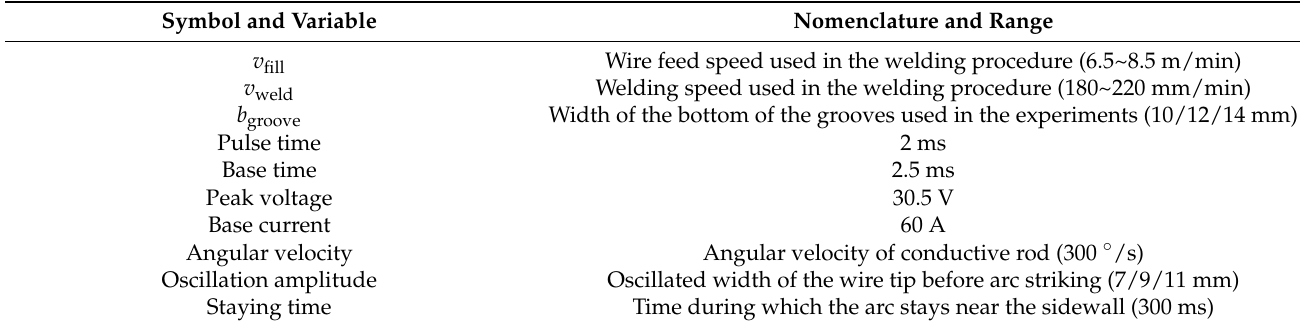
Table 2. Processing parameters set in the machines. Table 4. Experimental parameters and responses in the Box–Behnken design.